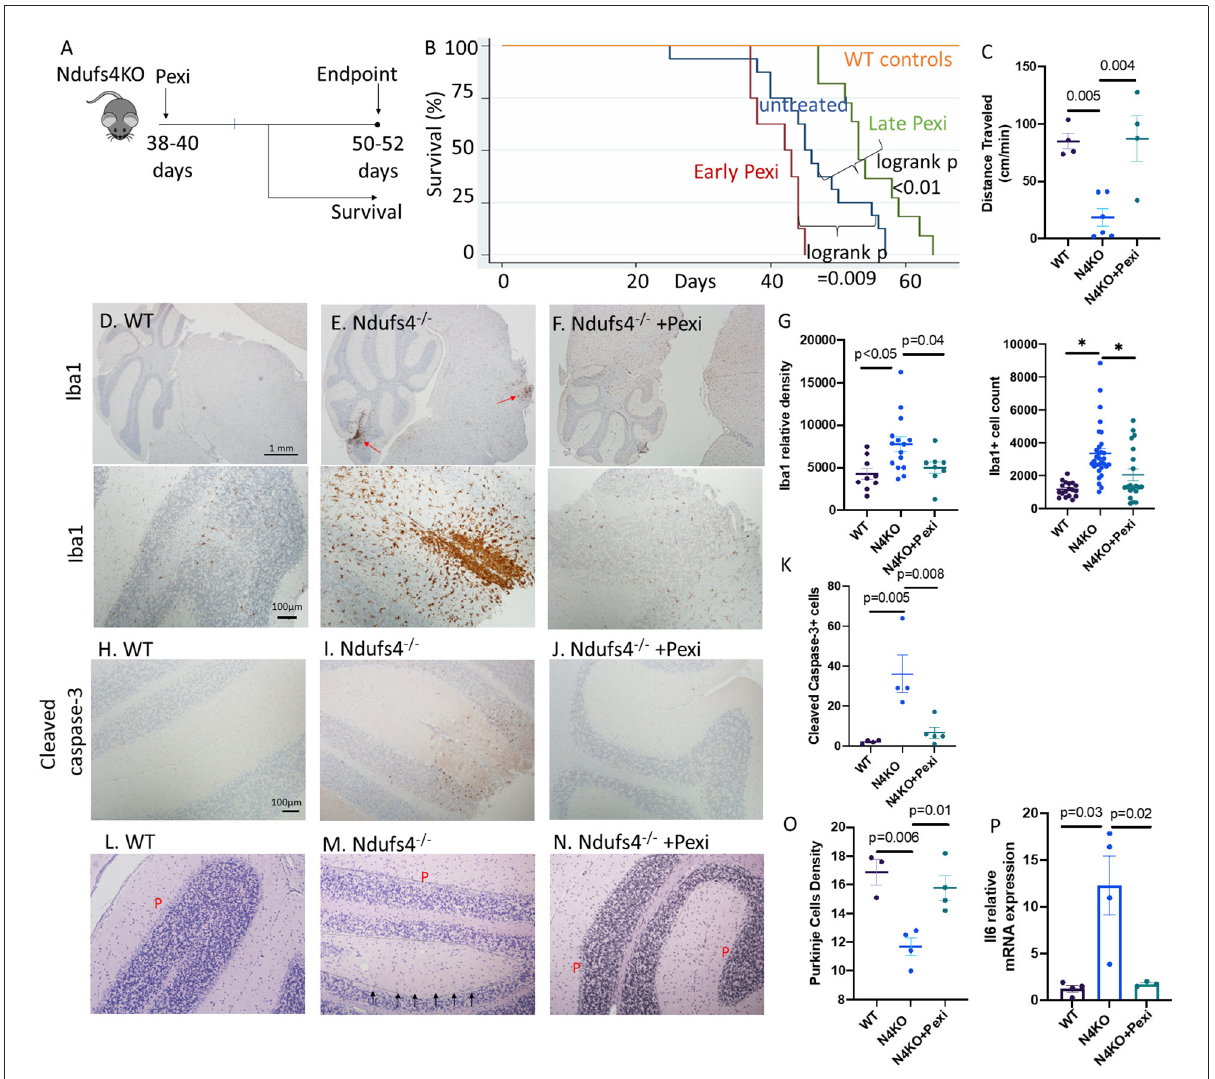
FIGURE3 (A) Experimental design. (B) Survival curves of Ndufs4 − / − mice, untreated or saline treated control ( n = 16), receiving early Pexidartinib ( n = 8, initiated at D28-37) or late Pexidartinib ( n = 11 initiated at D38-42). (C) Distance traveled (cm/min) in WT and N4KO (LS) mice untreated